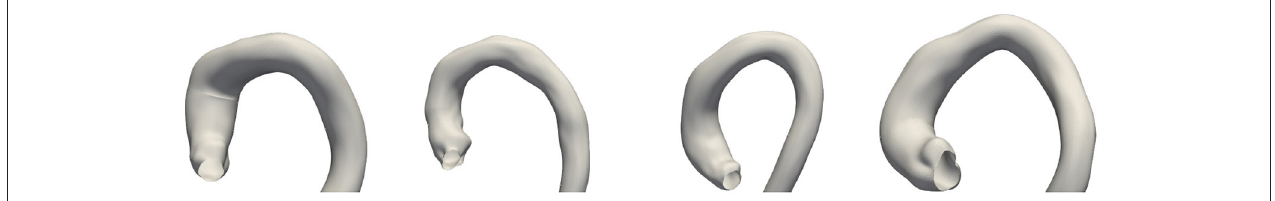
FIGURE 6 | Examples of four synthetic aortas with decreasing feasibility of the biomarkers according to the acceptance functions. From left to right: the first one is accepted by all of the criteria; the second one is rejected by A r , but not by the other acceptance functions; the third one is only accepted by A M and the last one is rejected by all the criteria.